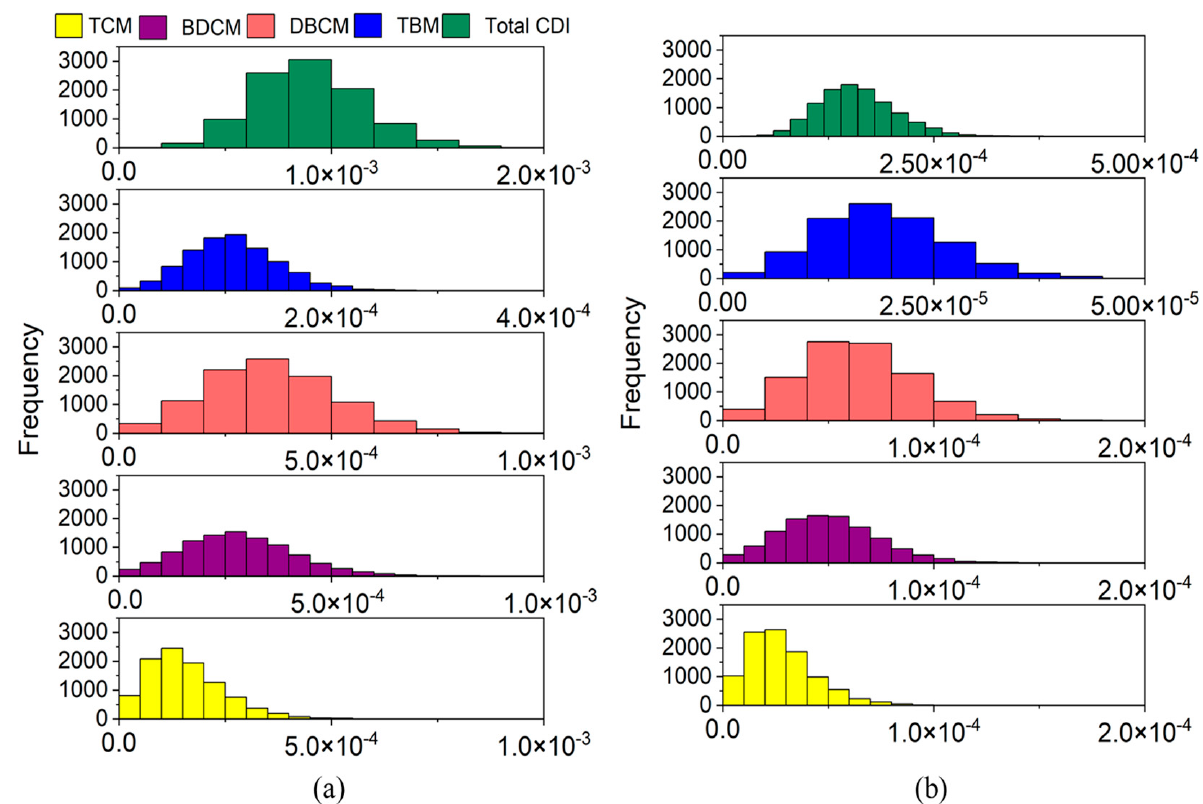
Figure 2. Frequency distribution of chronic daily intake of THM (mg kg − 1 day − 1 ) through ( a ) ingestion and ( b ) dermal contact. TCM: trichloromethane, BDCM: bromodichloromethane, DBCM: dibromochloromethane, TBM: tribromomethane, and CDI: chronic daily intake.